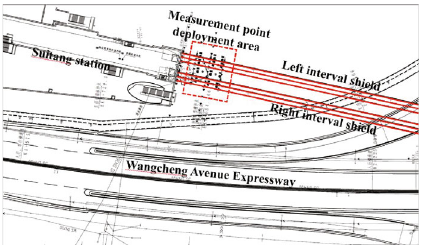
Figure 1: Shield tunnel measurement fi eld